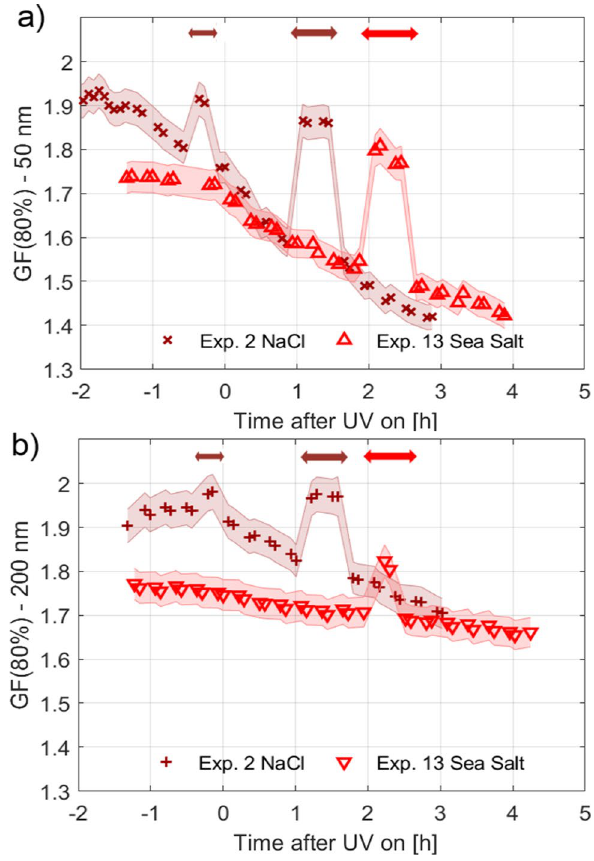
Figure 6. Effect of heating the aerosol particles. Growth factors at RH = 80% measured for NaCl and sea salt for the two different sizes of D dry = 50 nm ( a ) and 200 nm ( b ) are shown. The influence of heating the particles ◦ to 300 C, additionally to drying them, is illustrated. The arrows indicate the time period when the heating was switched